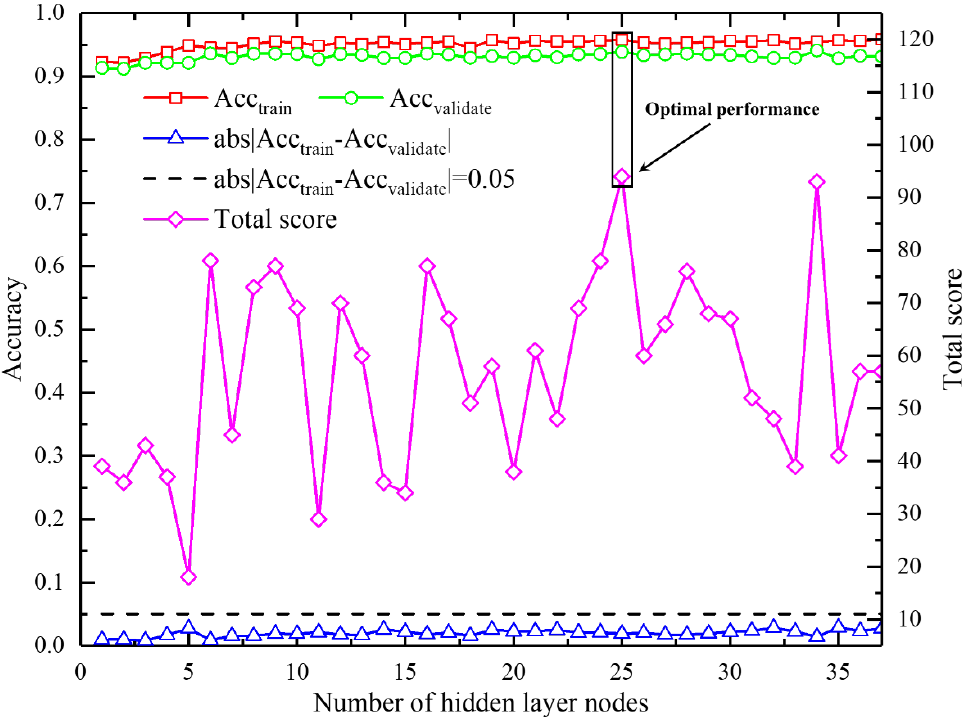
Figure 7. Prediction results of the BPNN models with various HLNs.